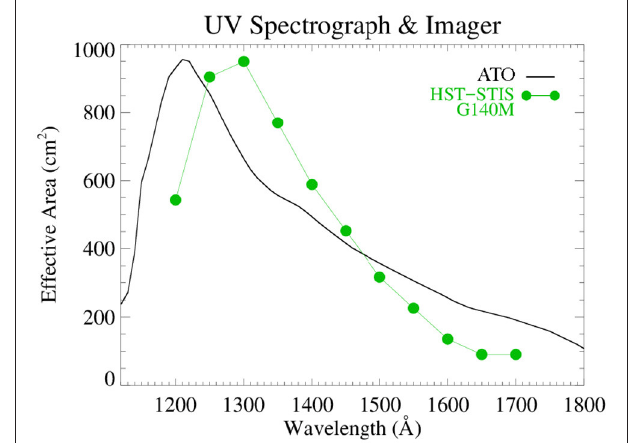
FIGURE 9 | MUVI FUV effective area. Through efficient design and modern componentry, the 1-m system provides comparable performance to the medium-resolution grating mode on HST-STIS (G140M). Note that STIS has higher spectral resolution while MUVI has a factor of ∼ 15 more spectral bandpass per